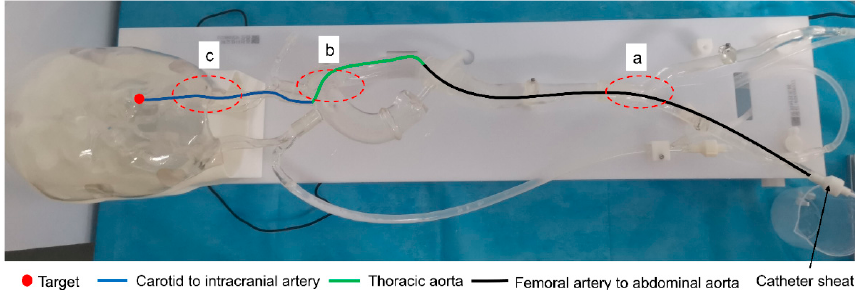
Figure 18. The in vitro model and experimental pathway. ( a ) Femoral artery to abdominal aorta junction. ( b ) Thoracic artery to carotid artery junction. ( c ) Carotid artery to target junction.